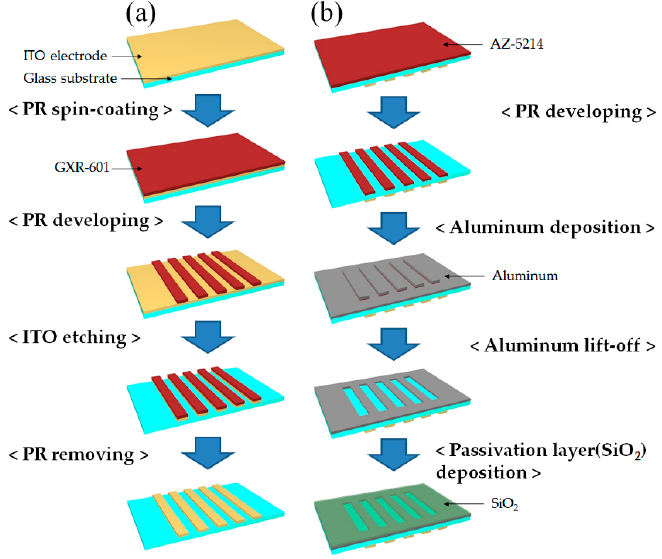
Figure 3. Fabrication process of the top substrate for the multiple slits and the aligned ITO patterns of the LC-based DFPG device: ( a ) ITO electrode patterning and ( b ) Al slit array patterning using the lift-off process.